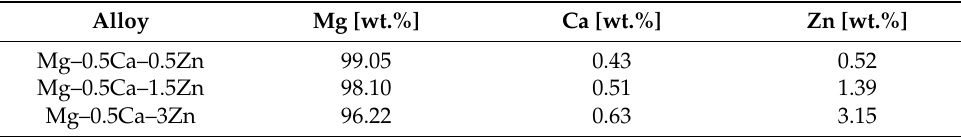
Table 3. Lattice parameters of the Mg–0.5Ca–xZn alloy